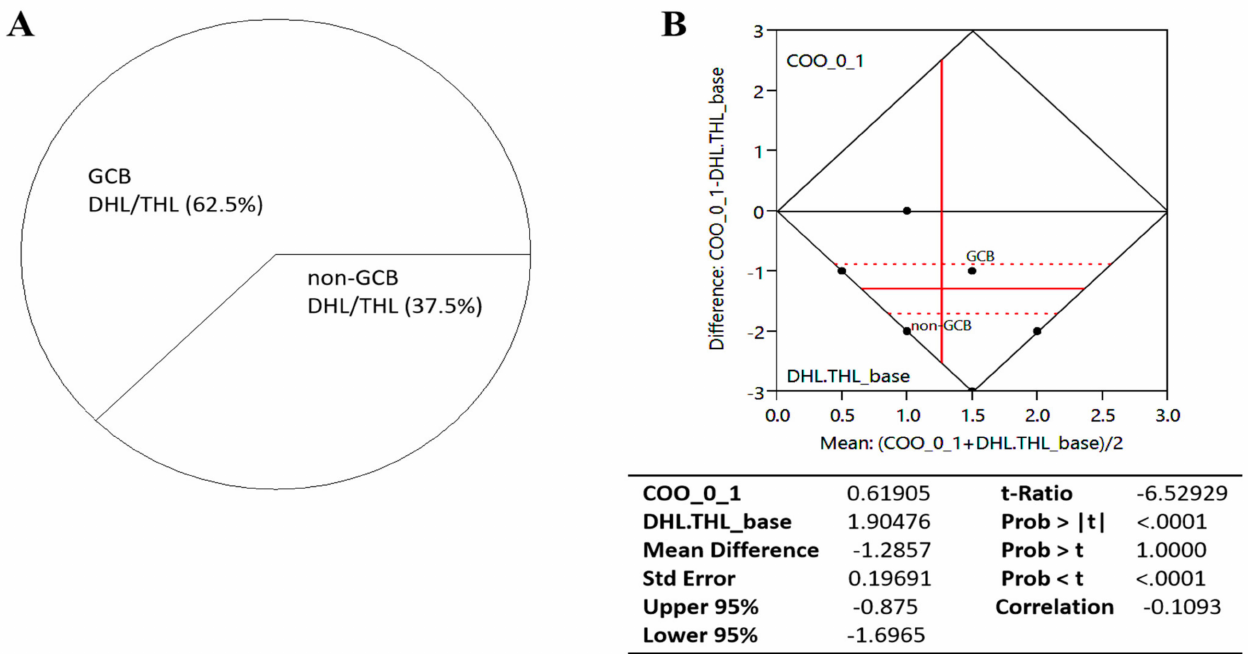
Figure 2. ( A ) Pie-chart showing the COO-based constitution of our high-grade B-cell lymphoma (HGBL) with MYC and BCL2 and/or BCL6 rearrangements ( n = 24). ( B ) Chart showing the difference between the means of our high-grade B-cell lymphoma (HGBL) with MYC and BCL2 and/or BCL6 rearrangements (DHL/THL) and their COO. DHL, double hit lymphoma; THL, triple hit lymphoma; DEL, double expressor lymphoma; TEL, triple expressor lymphoma; N, sample size; DF, degree of freedom; GCB, germinal center B-cell type; COO,